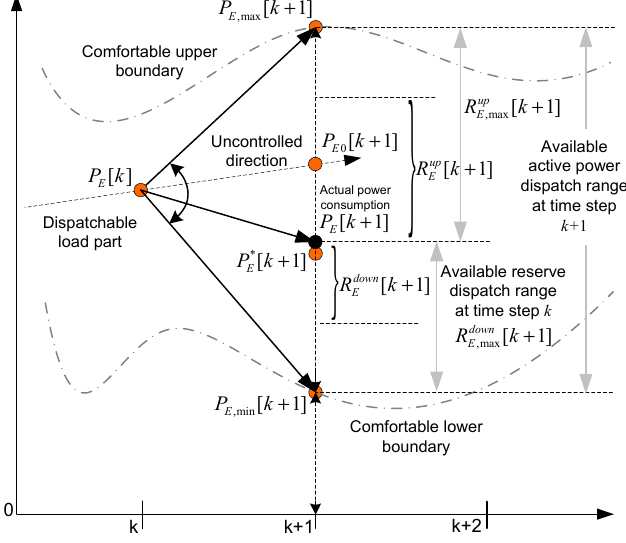
Figure 3. Definition of active power and the reserve range of an electrolyzer-based efficient power plant (EPP) model determined from the given user constrains.